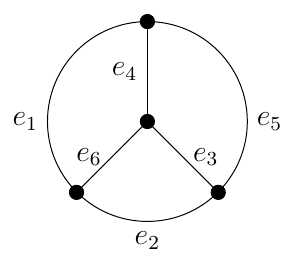
Figure 7 . The wheel with three